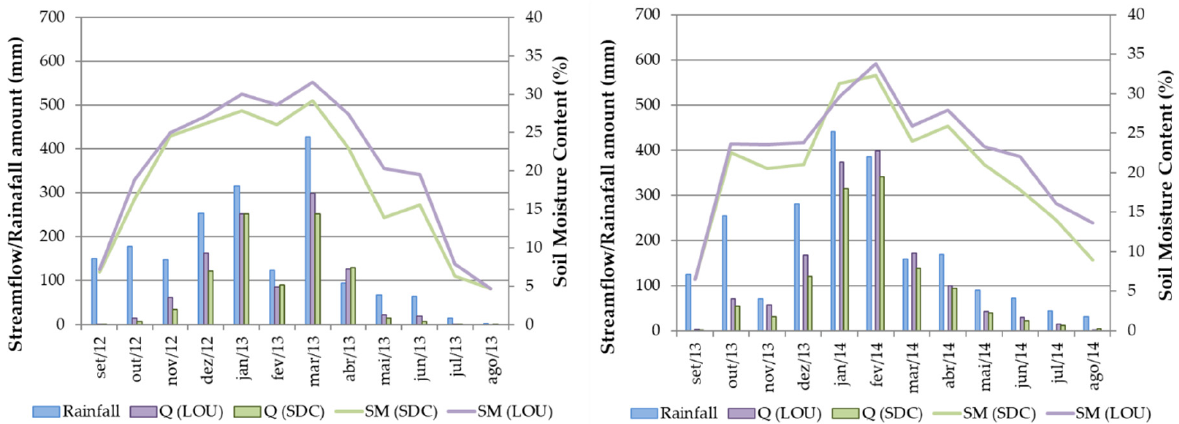
Figure 4. Average monthly rainfall, streamflow (Q) and soil moisture content (SM) for the hydrological years 2012/2013 (medium year; left side ) and 2013/2014 (dry year; right side ).